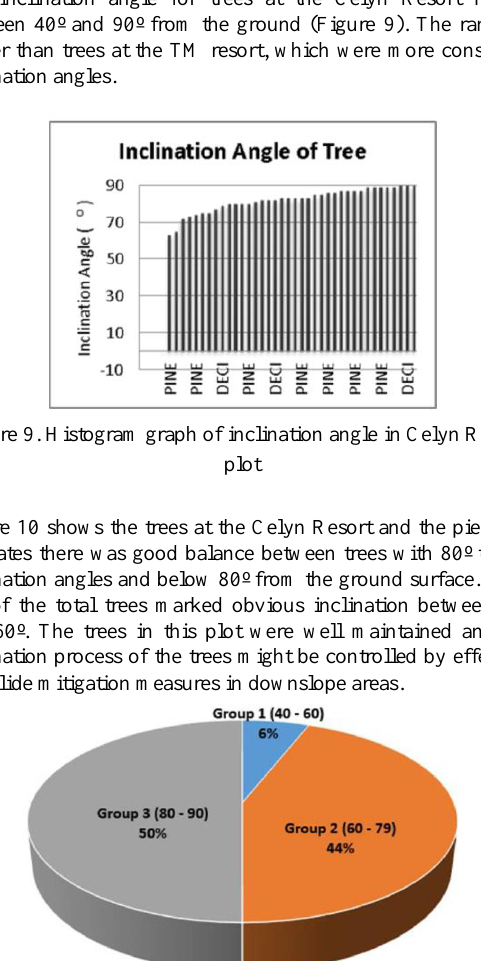
Figure 10. Percentage of trees according to the inclination angle at the Celyn Resort Trees at the Celyn Resort vary with age with 38%, 34% and 28% of the trees classified under 20-30cm, 10-19cm and 20- 35cm of DBH, respectively (Figure 11). About 38% of the trees DBH at the Celyn Resort plot were measured from small trees with DBH below than 10cm. Furthermore, since Celyn Resort management team has strong landslide hazards awareness, they continuously plant trees to reduce the impact of